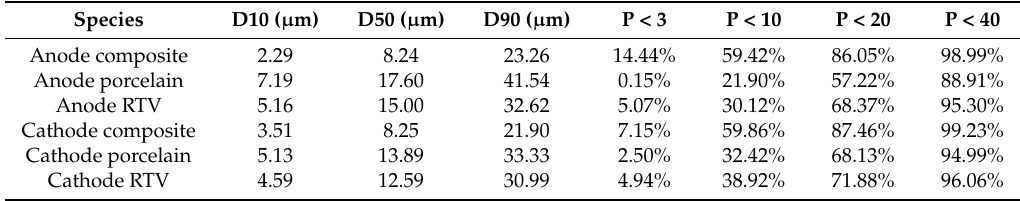
Table 3. The particle size distribution of the contamination.